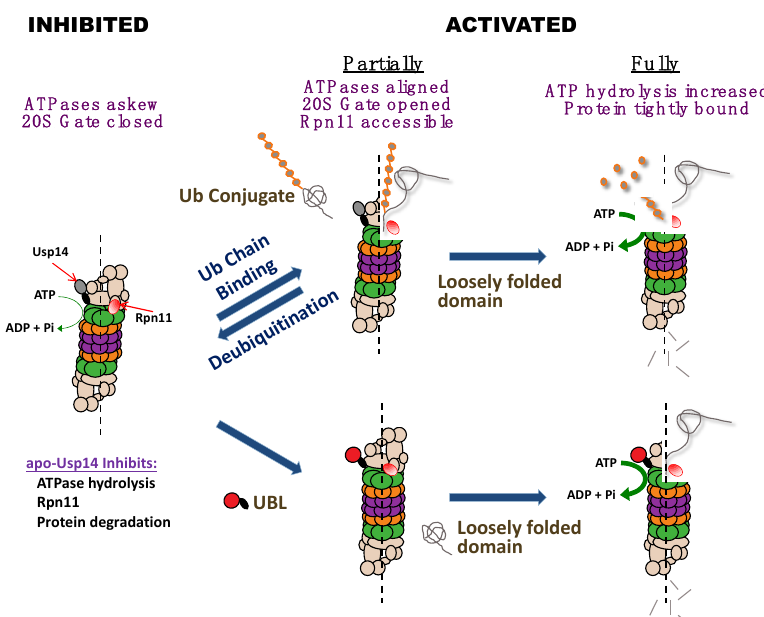
Figure 1. 26S proteasomes inhibited by Usp14 become activated either upon ubiquitin conjugate binding to Usp14 or upon binding another cell protein containing a UBL domain. In the absence of a ubiquitin conjugate, Usp14 inhibits several proteasome activities: peptide hydrolysis (due to the misalignment of ATPases and the closed 20S gate), ATP hydrolysis, Rpn11-mediated de-ubiquitination, and consequently protein degradation. However, upon binding to a ubiquitin conjugate, Usp14, through its UBL domain, activates proteasomes: the ATPases align, the 20S gate opens, and Rpn11 becomes accessible to substrates. If a loosely folded domain is also present in the substrate, proteasomes become fully active, ATP hydrolysis increases, and the protein substrate is bound more tightly, leading to processive degradation. Alternatively, the binding to the proteasome of a protein containing a UBL domain (e.g., a UBL-UBA shuttling factor) stimulates peptide hydrolysis. Full activation occurs if, in addition, there is present a protein with a loosely folded domain.